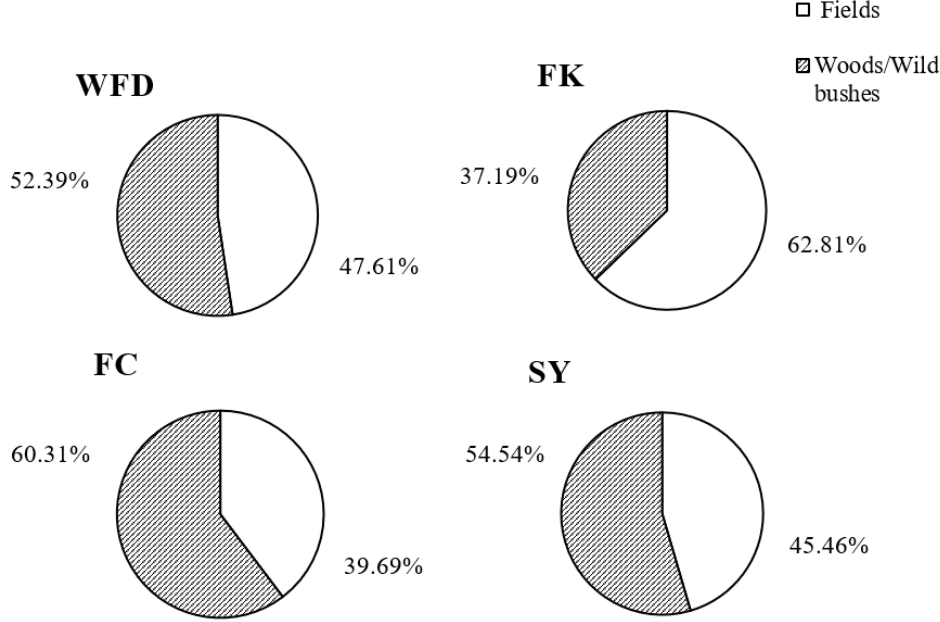
Figure 6. Relative abundance (mean ± SE) of D. suzukii adults captured from field and woody habi- tats.